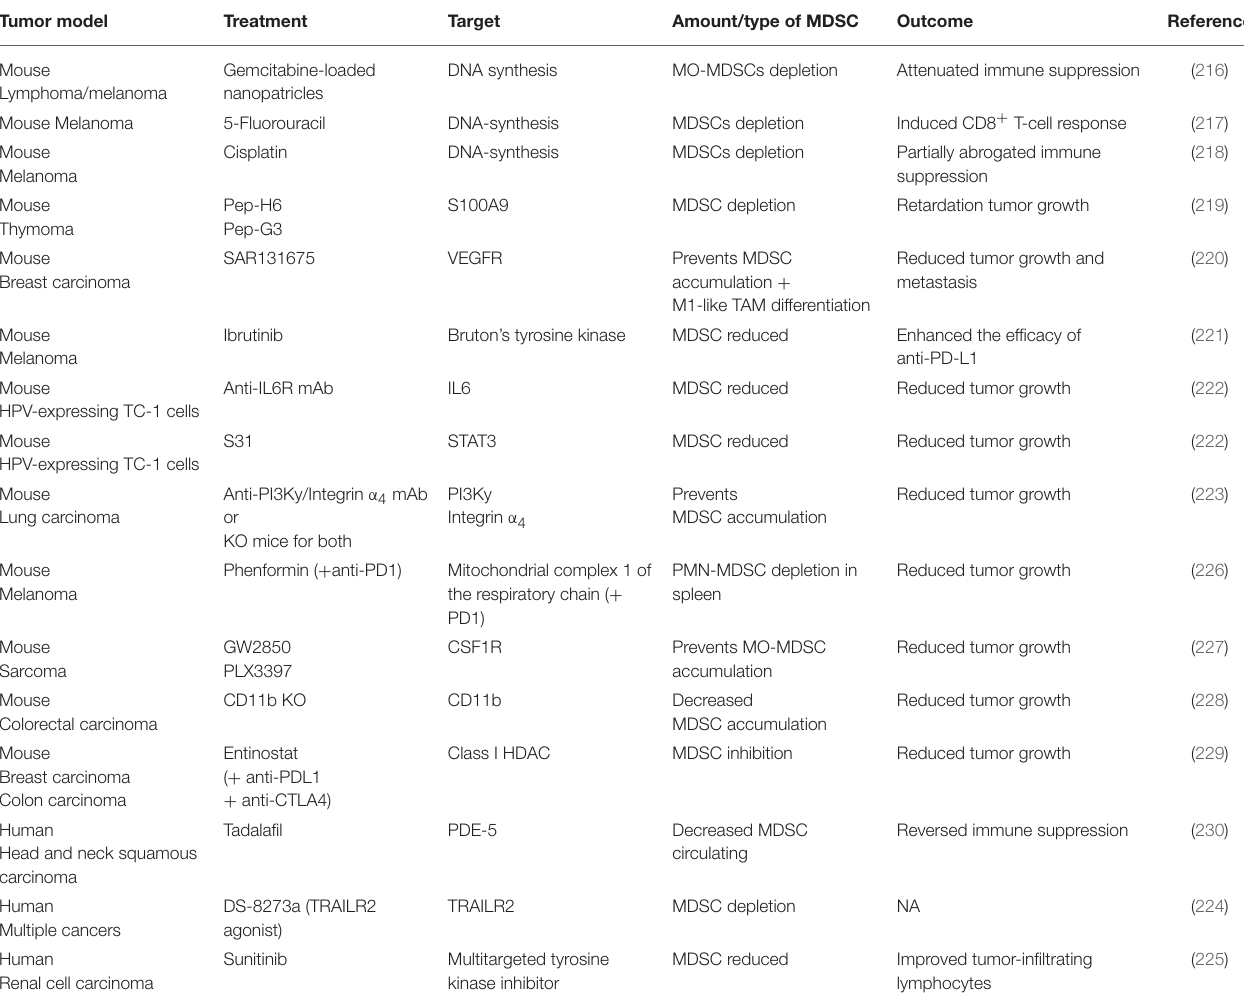
TABLE 1 | Myeloid-derived suppressor cell depletion or recruitment inhibition strategies in murine cancer models and